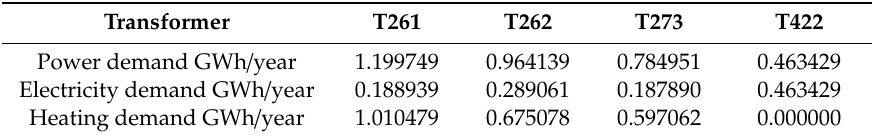
Table 2. Total power demand of the transformers.